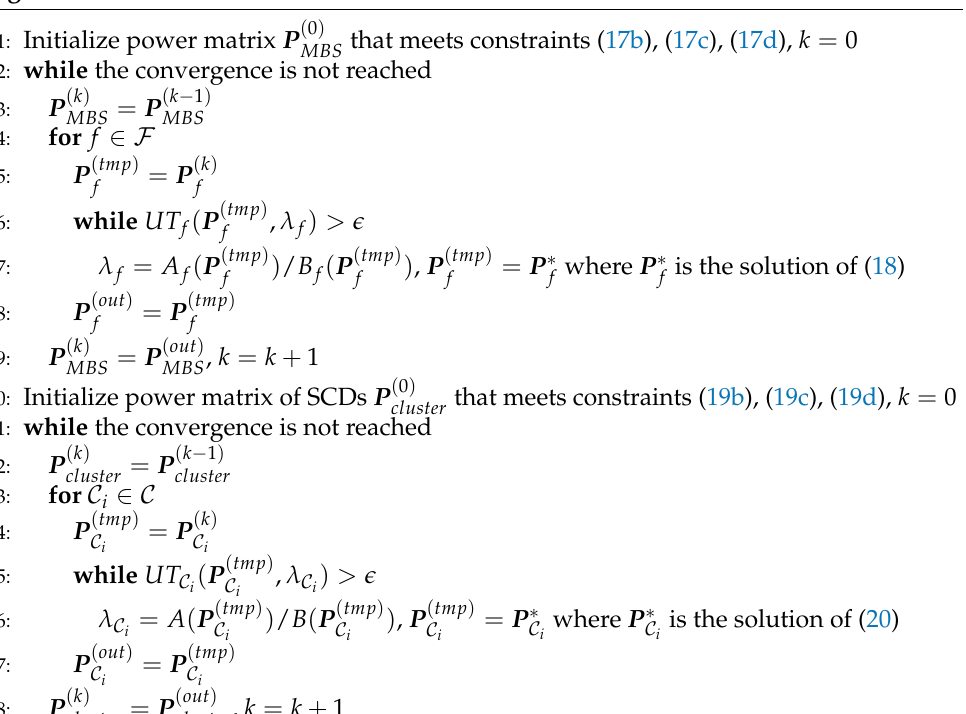
Algorithm 3 SG-based PA for macrocells and small